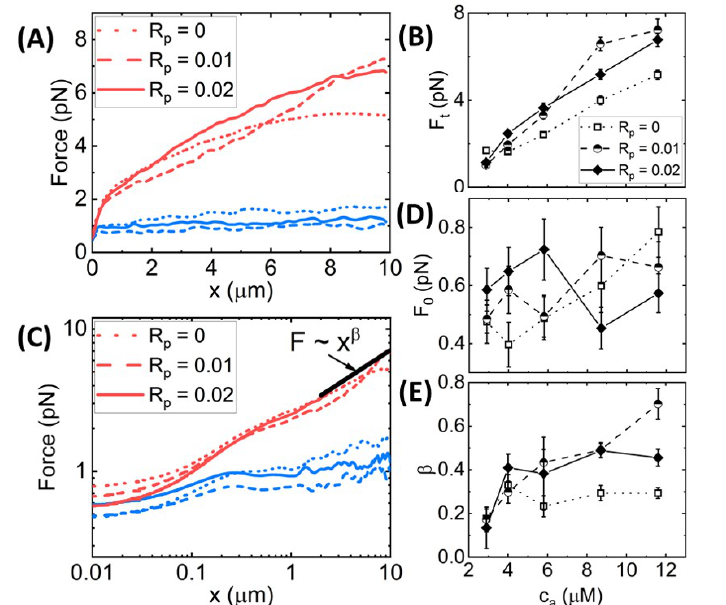
Figure 6. Effect of phalloidin stabilization and actin concentration on the nonlinear force re- sponse of entangled actin networks . ( A ) Force F ( x ) versus stage position x for actin networks subject to nonlinear straining (see Figure 1), for actin concentrations of c a = 2.9 µ m (blue) and c a = 11.6 µ m (red) and phalloidin:actin ratios of R p = 0 (dotted lines), R p = 0.01 (dashed lines), and R p = 0.02 (solid lines). ( B ) Terminal force reached at the end of the strain F t as a function of c a for R p = 0 (open squares, dotted connecting lines), R p = 0.01 (half-filled circles, dashed connecting lines), and R p = 0.02 (solid diamonds, solid connecting lines). ( C – E ) Data shown in ( A ) plotted on a log–log to highlight the trends seen for the initial force F ( x = 0 ) = F 0 (plotted in ( D )) and power-law scaling of F ( x ) near the end of the strain (plotted in ( E )). Error bars shown in ( B , D , E ) represent the standard error of values computed from the 30 individual trials that comprise each average force curve shown in ( A , C ) and SI Figure